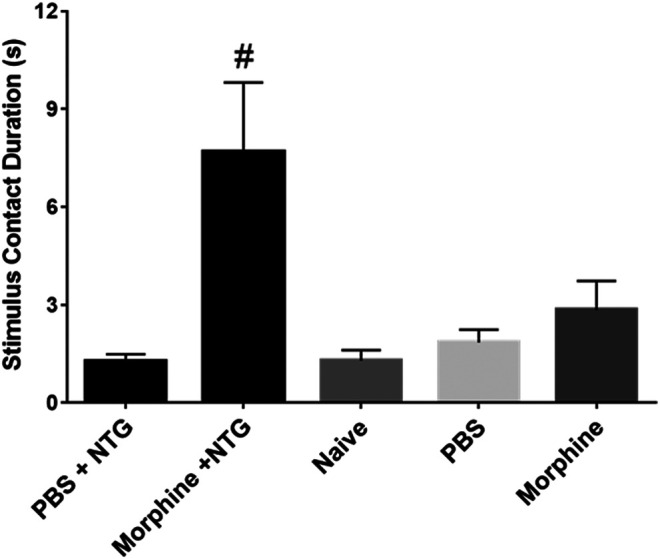
Effect of 10 mg/kg morphine (i.p.) and nitroglycerin on average stimulus contact duration in the OPAD assay (Mean ± SEM). One-way ANOVA: F (4, 45) = 6.297, p = 0.0004, #p < 0.05 Dunnett’s test when compared to PBS + NTG.